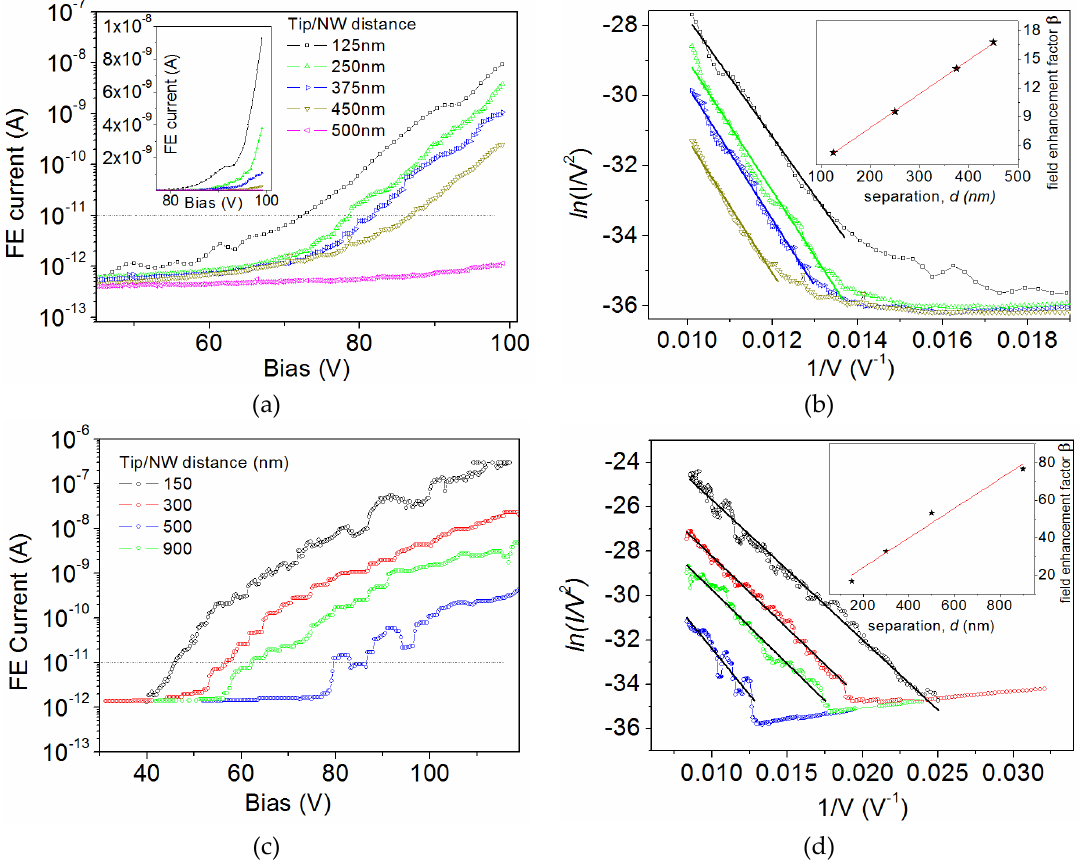
Figure 2. FE characterization of Sample-2 without Ga droplets. ( a ) Semi-log plot of the I − V characteristics measured for Sample-2 for different values of the separation d . Dotted line identifies the current level at which we define the turn-on field E ON . In the inset, the characteristics are reported in linear scale. ( b ) FN plots and linear fittings (solid lines). From the slope of fitting lines we extracted the field enhancement factor β , plotted as a function of d in the inset. ( c ) Semi-log plot of the I − V characteristics measured for Sample-2 for different values of the separation d in a different location of the sample. ( d ) FN plots and linear fittings (solid lines). Inset: β vs. d